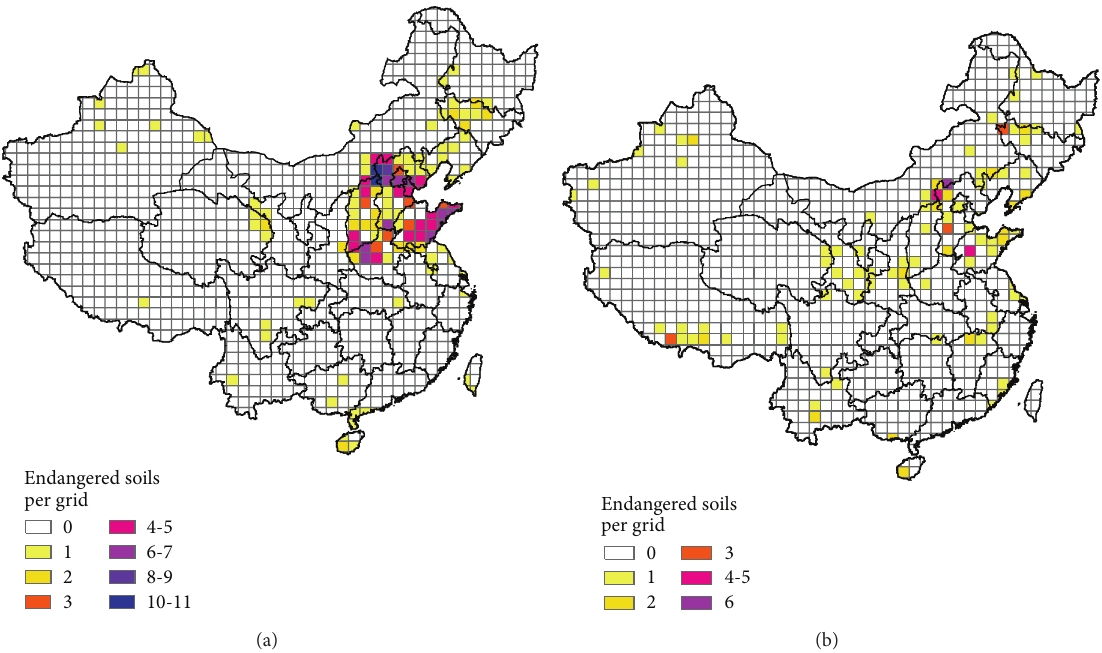
Figure 6: Endangered soils per grid based on soil map (a) and based on soil profiles (b) in China (the taxonomic level of the soil map is shown in Figure 1).